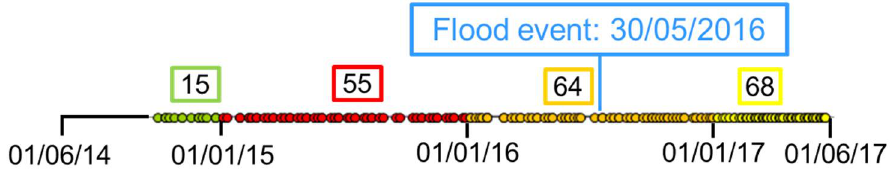
Figure 2. Sentinel-1 time-series information available for the study area within the period 1 June 2014–31 May 2107.